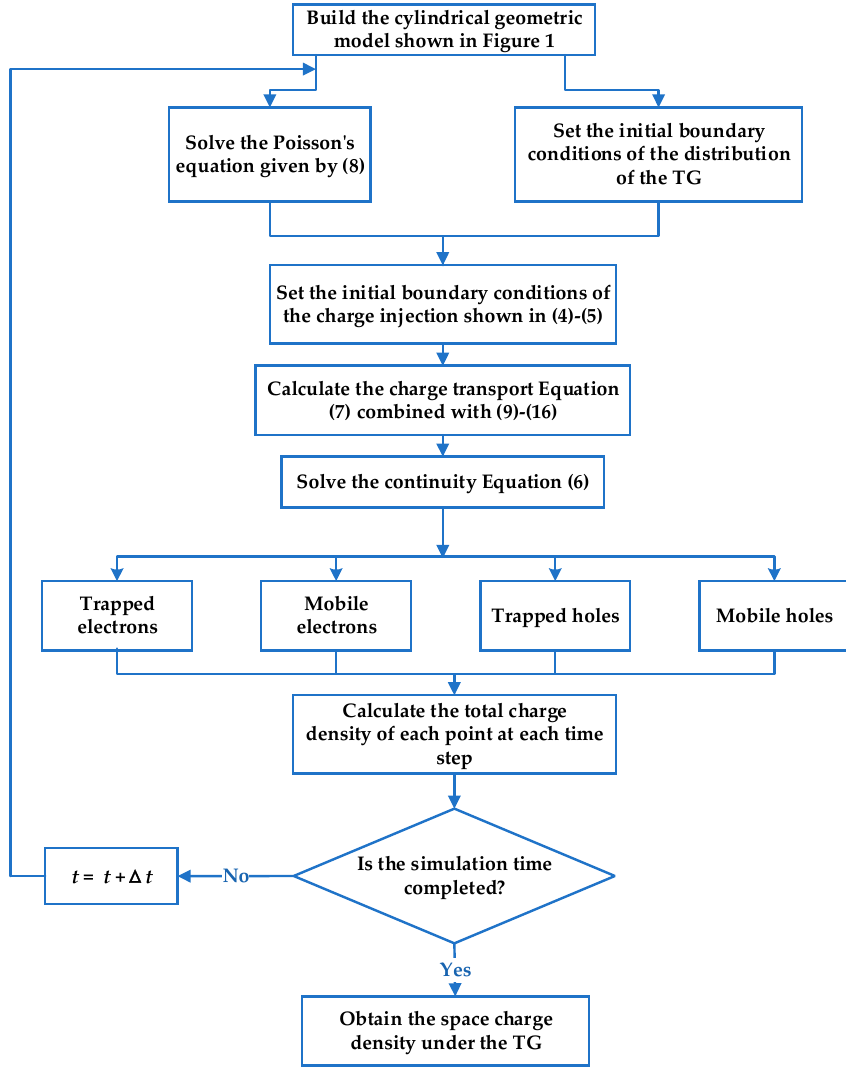
Figure 10. The flow chart of the simulation based on the BCT model. Table 3. Simulation parameters based on the BCT